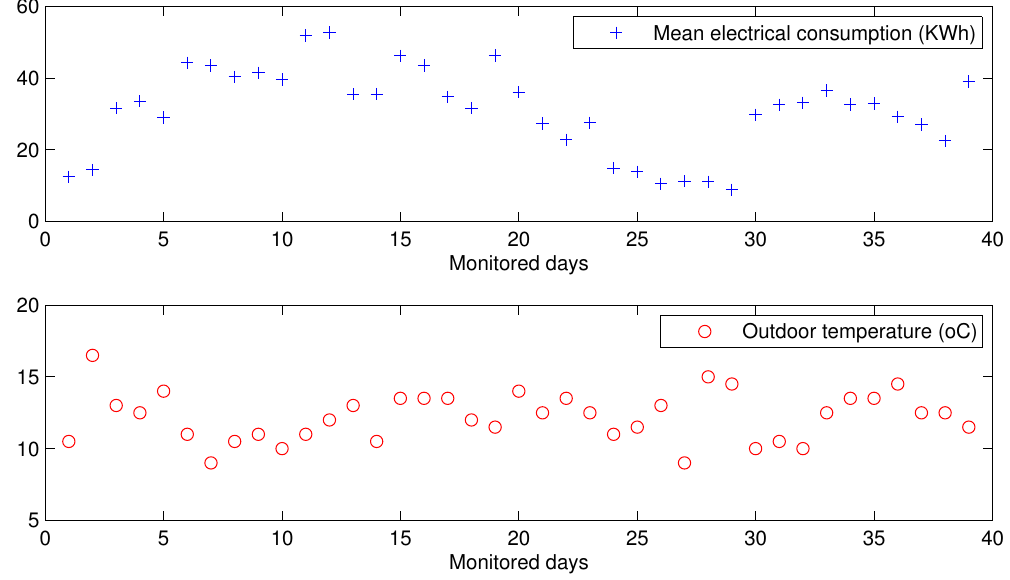
Figure 13. Evolution of the consumed electrical power and the outdoor